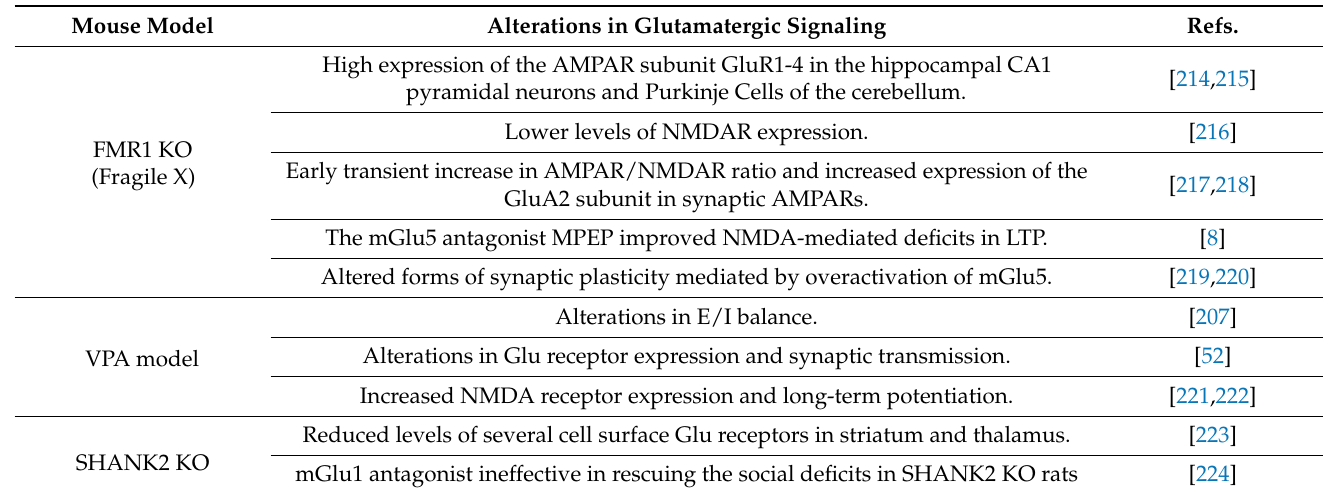
Table 2. Glutamatergic dysfunctions reported in pharmacological and genetic animal models of ASD. Mouse